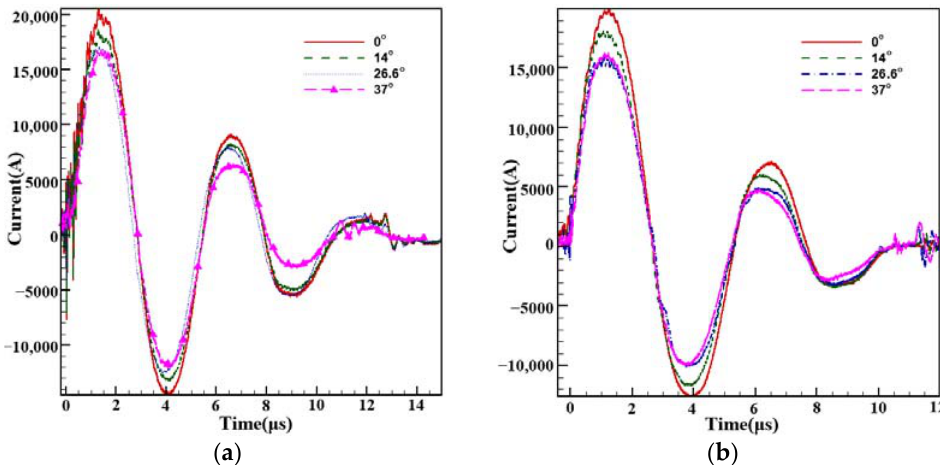
Figure 11. The tongue-shaped electrode APPT discharges current waveforms at various electrode flare angles: ( a ) the electrode spacing is 3 mm and ( b ) the electrode spacing is 25 mm. Table 3. The tongue-shaped electrode APPT discharge circuit parameters at various electrode flare angles. Electrode Spacing